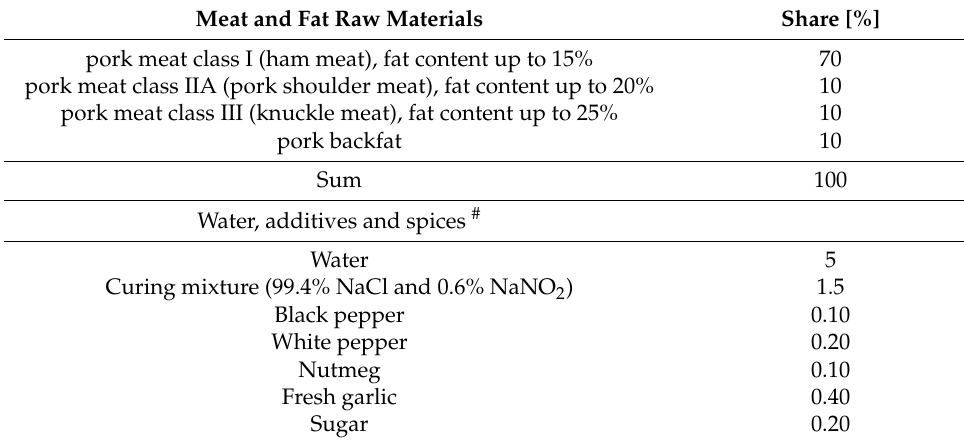
Table 1. Composition of KSS sausages. Meat and Fat Raw Materials Share [%] pork meat class I (ham meat), fat content up to 15% 70 pork meat class IIA (pork shoulder meat), fat content up to